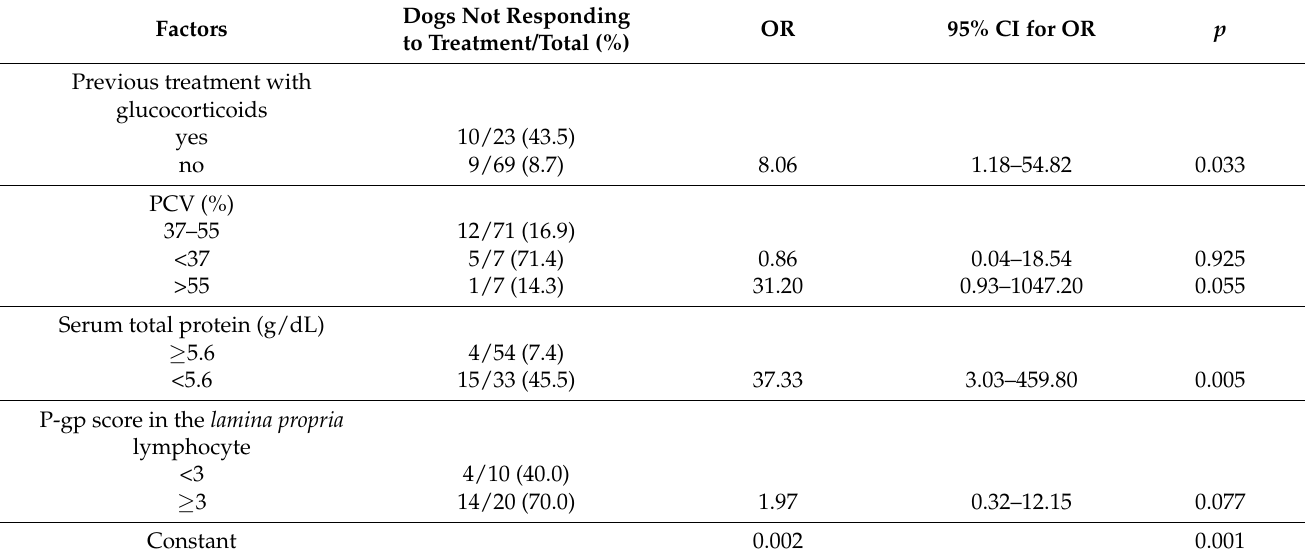
Figure 2. Sections of the duodenum from dogs with IRE. Immunohistochemical evaluation of the epithelial and the lamina propria infiltrating lymphocytes; P-gp antibody immunohistochemistry, Streptavidin-biotin immunoperoxidase technique (brown stain). ( a ) Focal, strong cytoplasmic expression of P-gp in enterocytes, reinforced on the apical luminal portion (arrows), scale bar: 100 µ m. ( b ) Diffuse, mild, with focal expression at the tips of the villi. Note the strong positivity also in numerous submucosal lymphocytes (arrow), scale bar: 300 µ m. ( c , d ) Infiltration of the duodenal lamina propria with a scarce number of P-gp positive lymphocytes (score 2). There is no expression of P-gp at the enterocytes; scale Bar: 100 µ m. ( e ) Strong P-gp positivity in a moderate number of laminae propria lymphocytes (score 3); scale bar: 300 µ m. ( f ) Strong and diffuse P-gp expression in the lymphocyte submucosal infiltrate (score 4). Note the marked focal positivity also in the apical portion of the duodenal epithelial cells (arrows); scale bar: 300 µ m. Table 3. Results of logistic regression